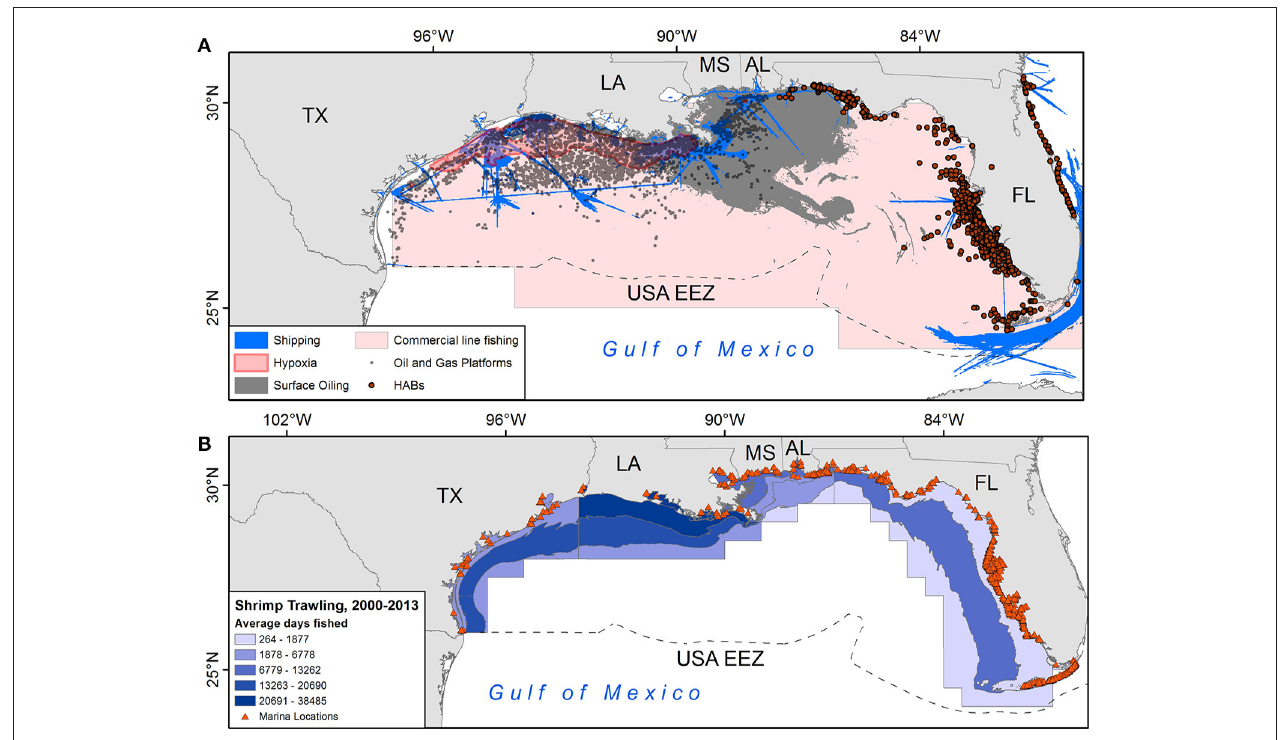
FIGURE 2 | (A) Spatial depiction of six anthropogenic threats in the GoM; (B) intensity of shrimp trawling by National Marine Fisheries Service (NMFS) statistical zone and locations of marinas. See supplemental methods for details on each